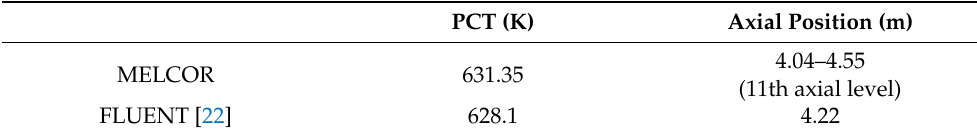
Table 6. The MELCOR-FLUENT comparison—PCT [30].